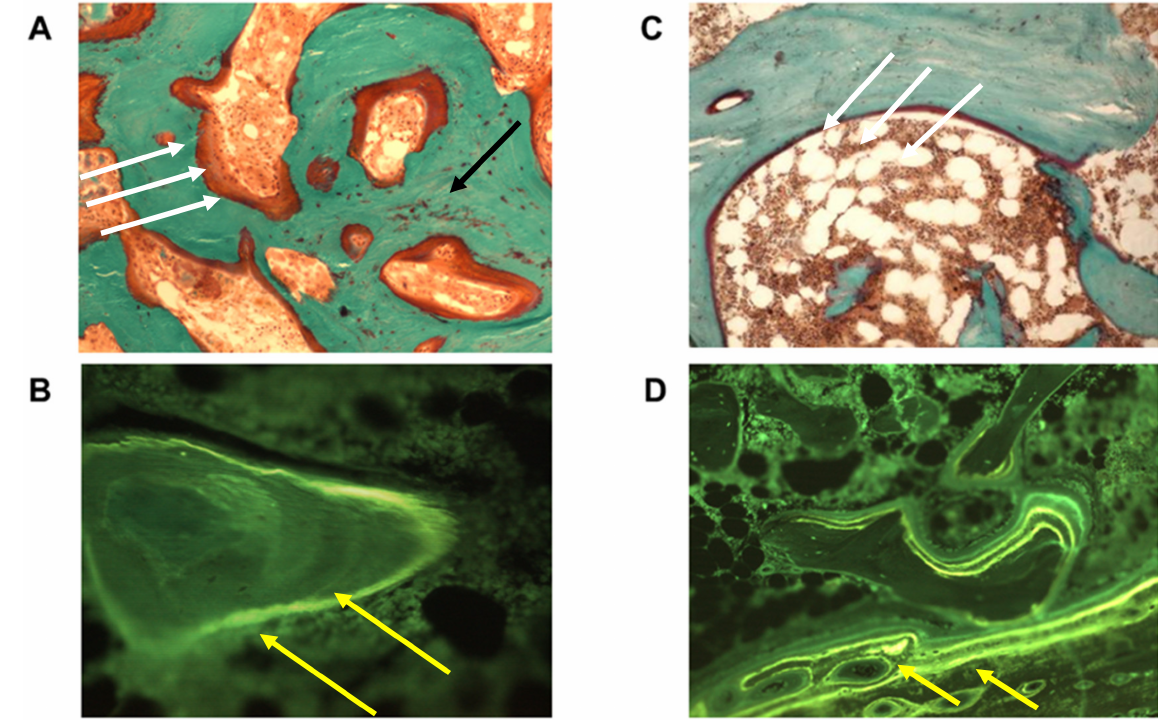
Figure 2. Histological section of the jaw. Left panels show biopsy from patient with Osteonecrosis of the jaw (ONJ), Goldner-stained ( A ) and tetracycline double labeling sections ( B ). Right panels represent an age-matched control subject. Note the large quantity of unmineralized osteoid (( A ), red color, white arrows), area of woven bone (( A ), black arrow), lacking the double labeling (( B ), yellow arrows) in ONJ compared to control ( C , D ). These findings represent the histological pattern of a mineralization defect (magnification 200 ×